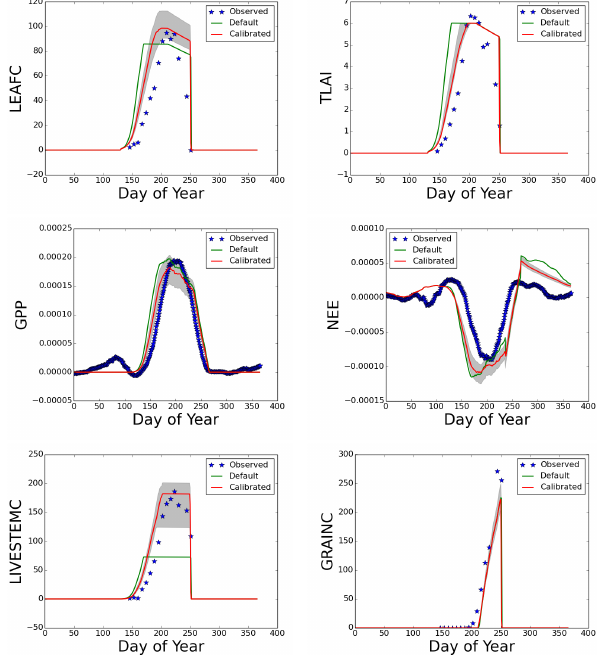
Figure 5. Calibration experiment (Bondville, IL): comparison of the observed data for 2004 with calibrated outputs. The grey areas correspond to 95% confidence error